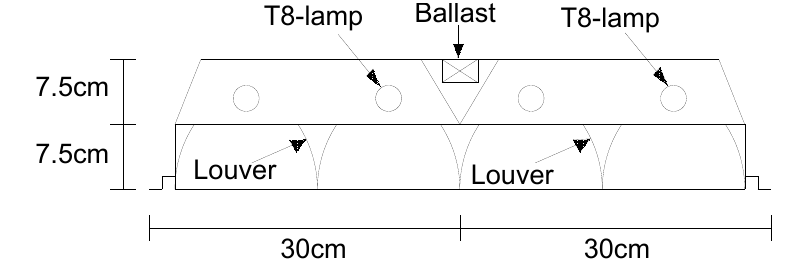
Figure 2. Section of fluorescent lighting